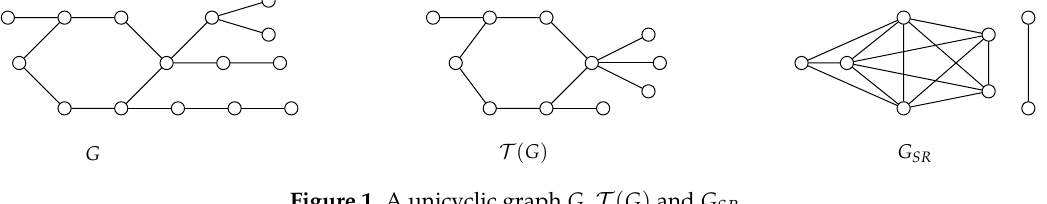
Figure 1. A unicyclic graph G , T ( G ) and G SR